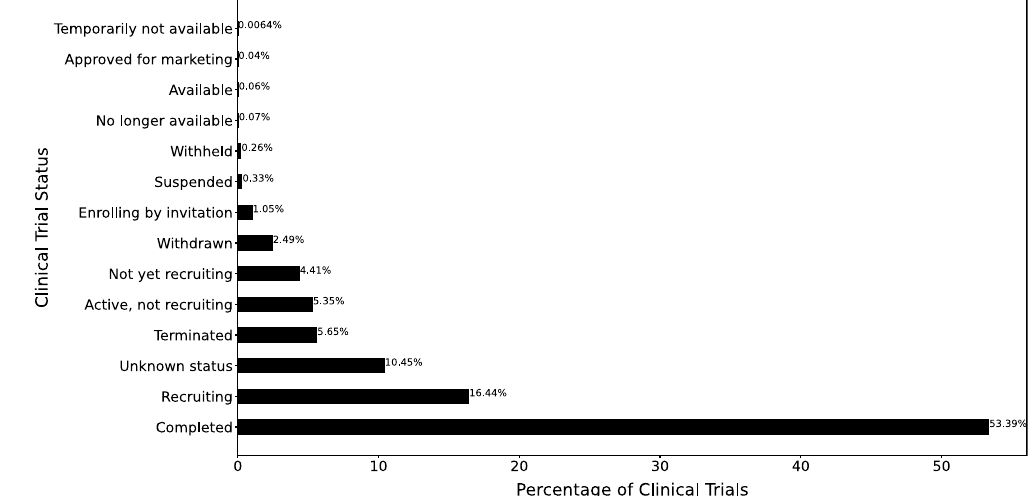
Figure 1. Summary of clinical trial statuses. The x -axis shows the % of clinical trials, and the y -axis shows the trial status.